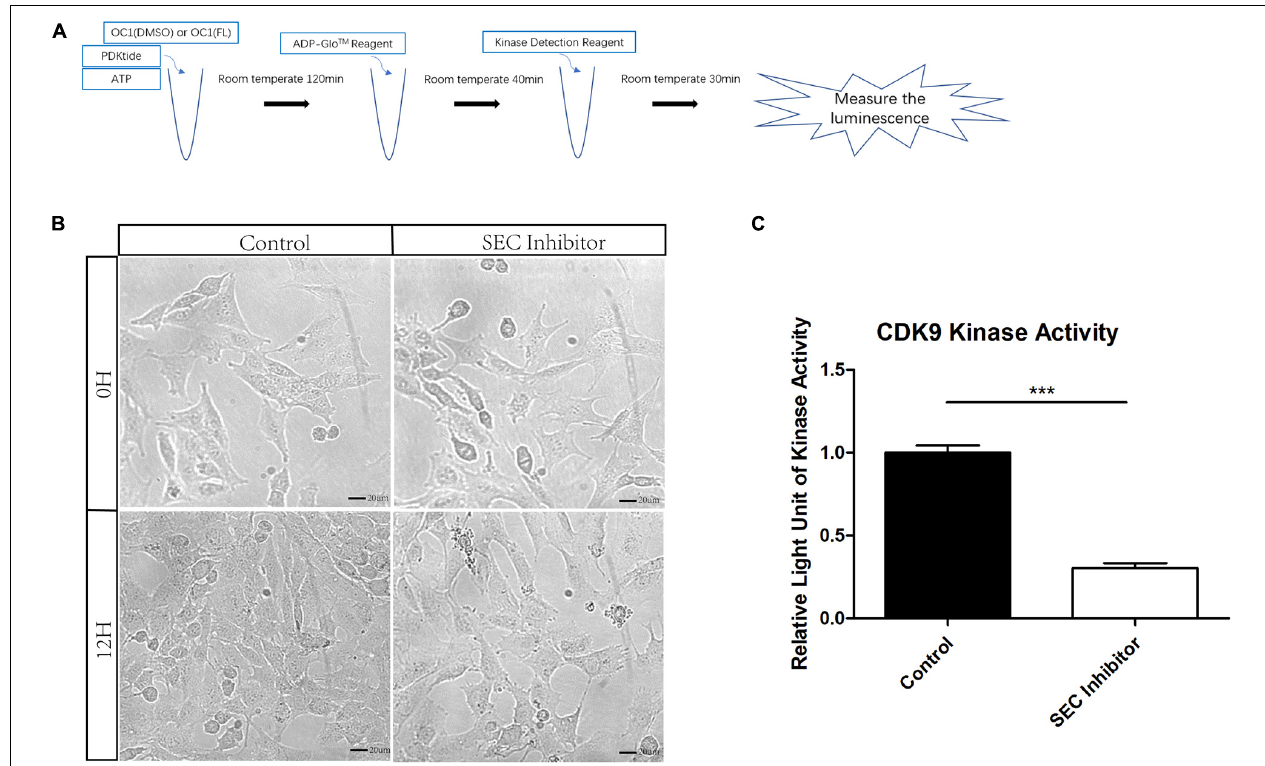
FIGURE 3 | The activity of cyclin-dependent kinase 9 (CDK9) in HEI-OC1 cells before and after Flavopiridol treatment. (A) HEI-OC1 cells after ultrasonication were incubated with CDK9 substrate PDKtides and ATP for 120 min at room temperature. The ADP which was consumed during CDK9 kinase assay was converted to ATP and could be quantitated by luciferase assay. (B) Images of HEI-OC1 cells before and after 10 µ M Flavopiridol treatment. DMSO was added as control treatment in the Control group. Scale bar = 20 µ M. (C) Fold change of CDK9 kinase activity in HEI-OC1 cells with or without Flavopiridol treatment. n = 3, *** p <